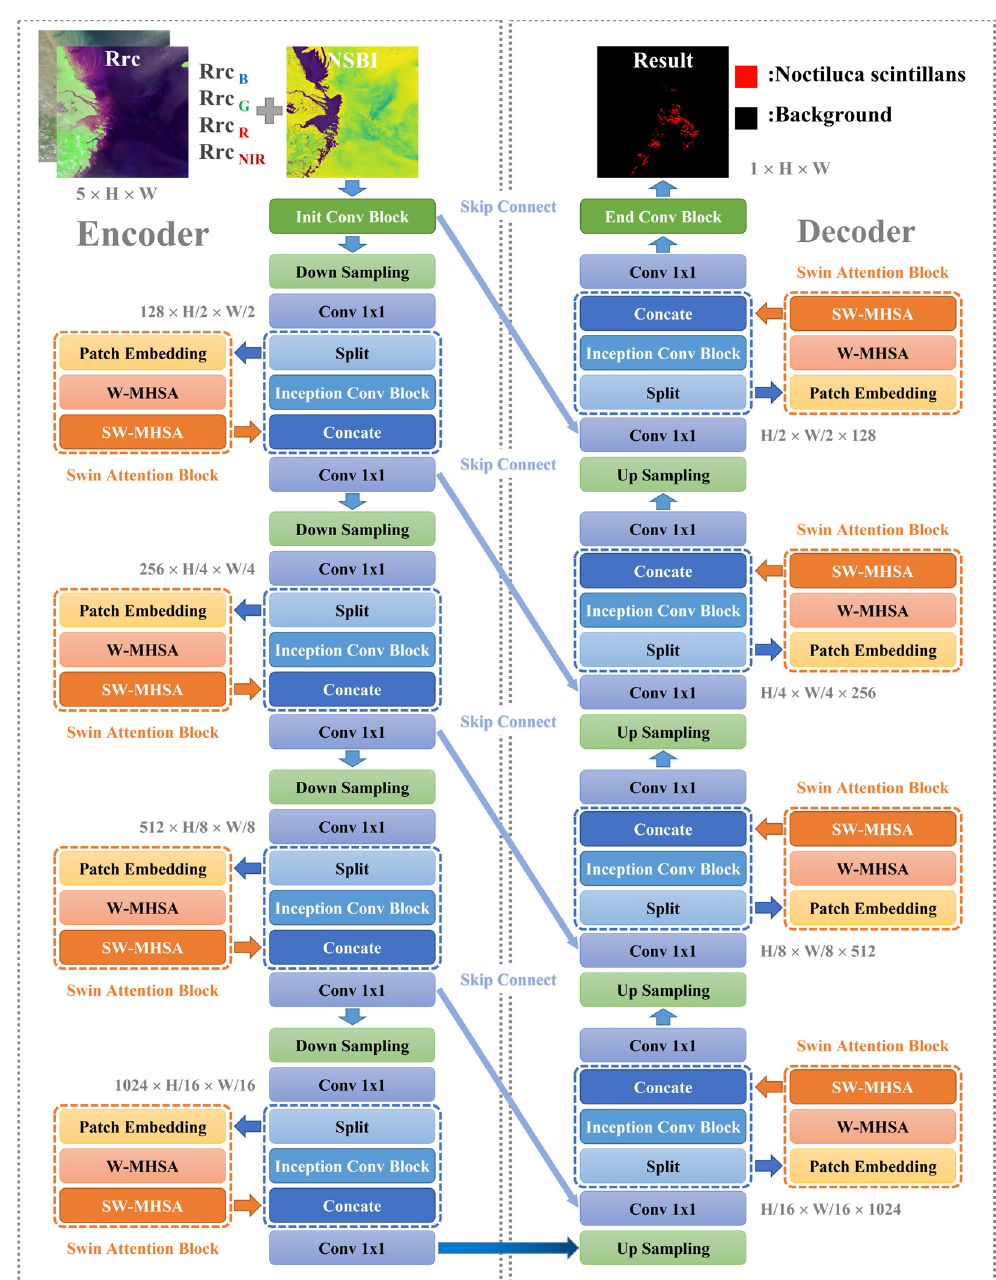
Figure 7. The model structure of NSBRNet.